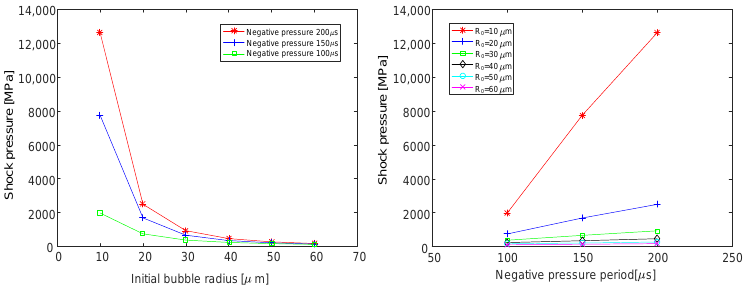
Figure 11. Relation between negative pressure and initial bubble radius R 0 on maximum shock pressure at constant standoff distance 1000 µ